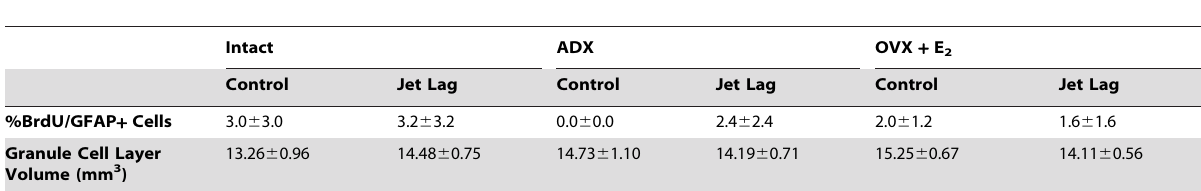
Table 1. Jet lag does not affect gliogenesis and hippocampal